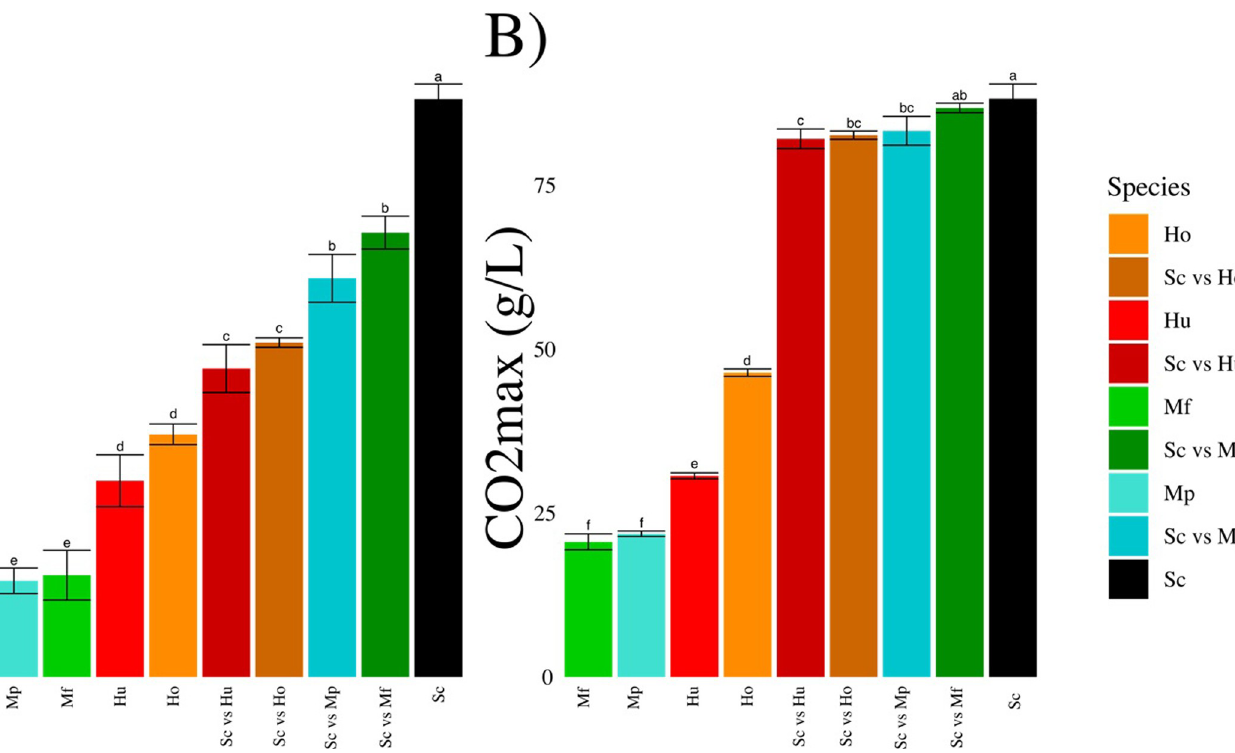
PLOS ONE | https://doi.org/10.1371/journal.pone.0233285 May 26,